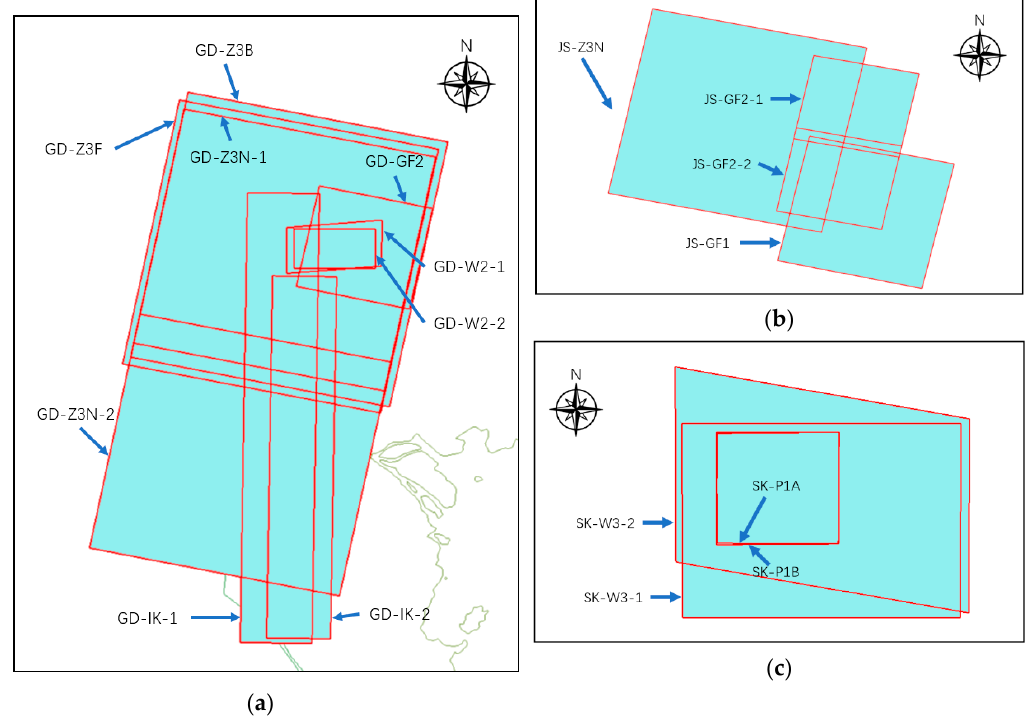
Figure 5. The relative positions of the tested satellite images: ( a ) the Guangdong test area; ( b ) the Jiangsu test area; and ( c ) the South Korea test area.